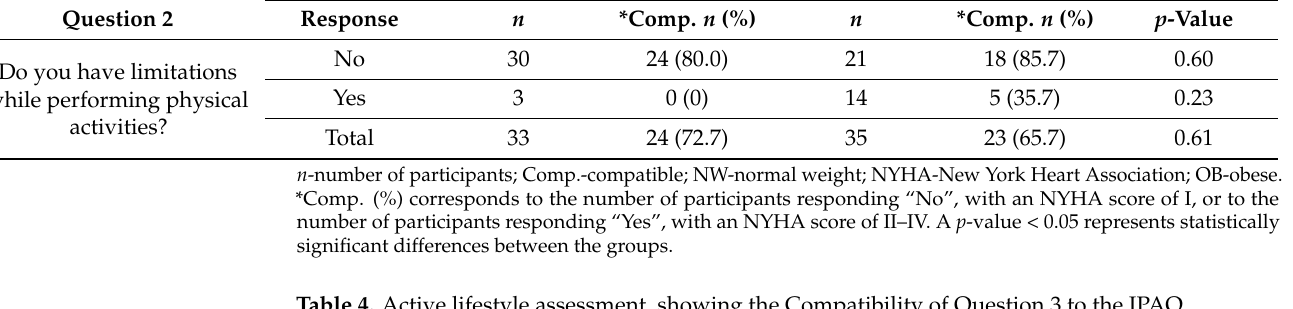
Table 4. Active lifestyle assessment, showing the Compatibility of Question 3 to the